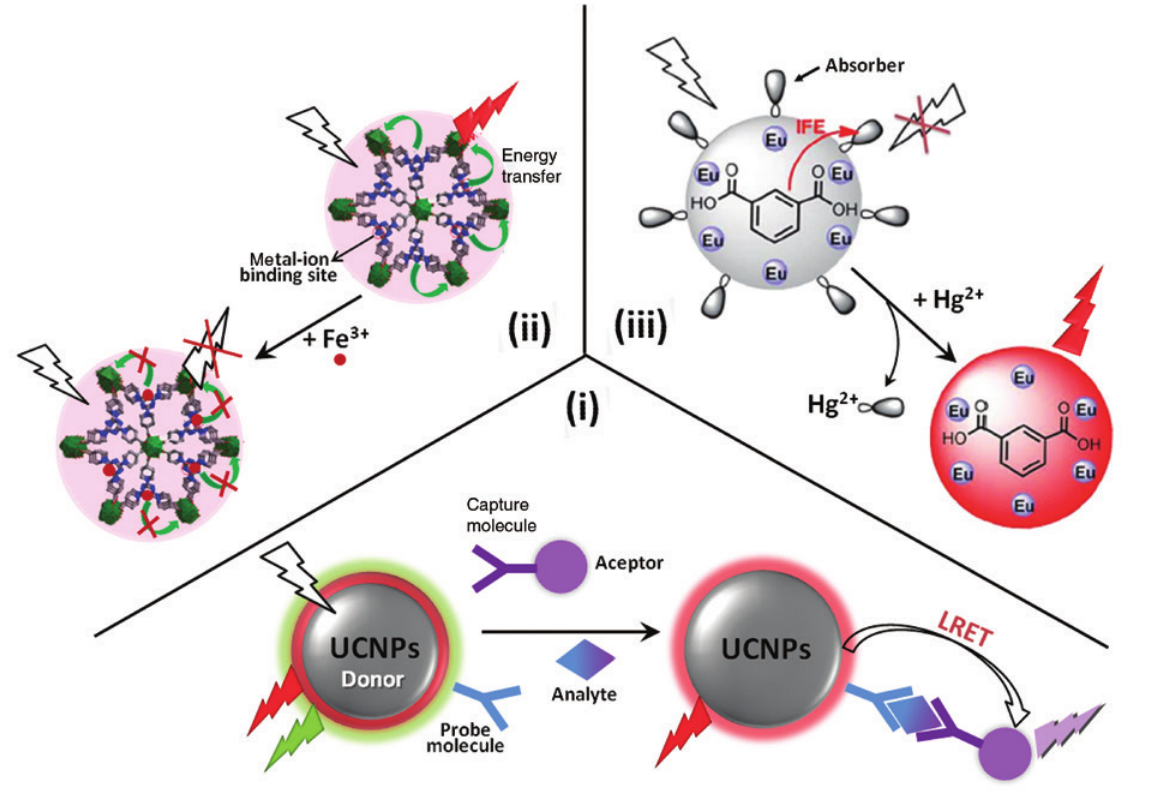
Figure 21: Different mechanisms involved in the optical response of the Ln-based sensing systems. (i) LRET. A UCNP donor produces anti-Stokes emission upon excitation. Consequently, it can excite the attached acceptors via FRET process. The intensity of the sensitized emission from the acceptor is proportional to the analyte concentration in the reaction. (ii) ET mediated by a ligand. After excitation of the ligand, there is an ET to the emissive states of the Eu 3 + ion. Complexation following the introduction of metal-ion guests into the MOF channels perturbs the electronic structure of the ligand. These changes, in turn, affect the efficiency of the ET process, and hence the observed changes in the luminescence intensity (adapted from [326]. Reproduced with permission of the American Chemical Society. Copyright © 2013). (iii) Emission-reabsorption (IFE). After excitation of the ligand, there is an ET to the emissive states of the Eu 3 + ion. When an absorber molecule is present, this absorbs the light emitted by the Eu 3 + ion, and consequently there is a quenching of the fluorescence. If the analyte forms a complex with the absorber molecule, the fluorescence is recovered due to the suppression of the IFE process (adapted from [324]. Reproduced with permission of The Royal Society of Chemistry. Copyright ©